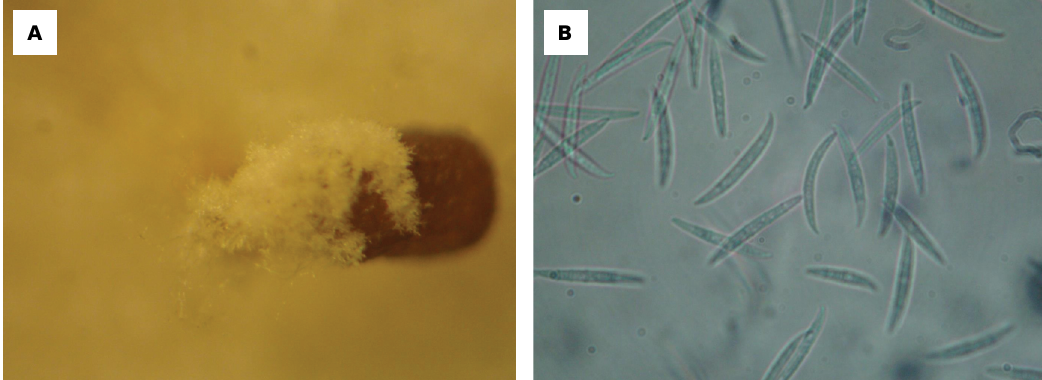
Figure 3. (A) Growth of Fusarium pallidoroseum in tobacco seed; (B) conidia of F. pallidoroseum